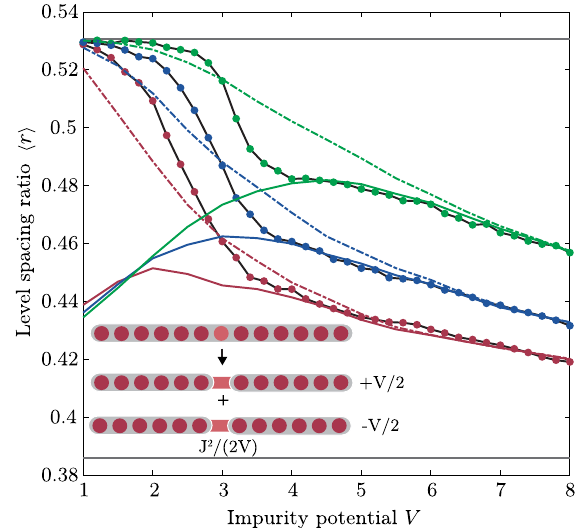
FIG. 6. Level spacing statistics: mean ratio of energy level spacings h r i as a function of the impurity potential for Heisenberg chains of length L ¼ 13 , 15, 17 (red, blue, and green, respec- tively) with a single impurity on the central site (black lines with circles). The dash-dotted lines show the level spacing ratio h r i for the effective model where the impurity is frozen and right-left sides of the chain interact only through a virtual process involving the impurity. The full lines result from folding the spectrum of the effective model, resulting from the two possible energies asso- ciated with the conserved charge of the